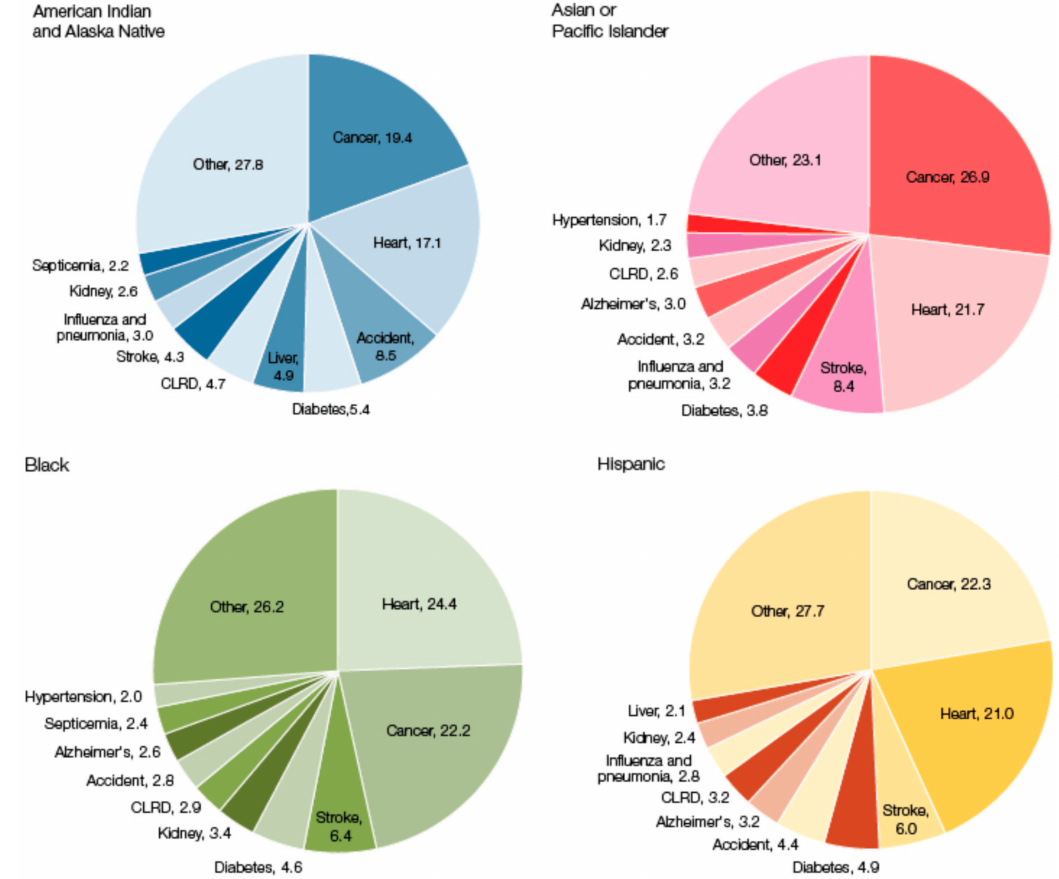
Figure 3. The causes of death for women by race and ethnicity. (Reprinted from the Women of Color Health Data Book